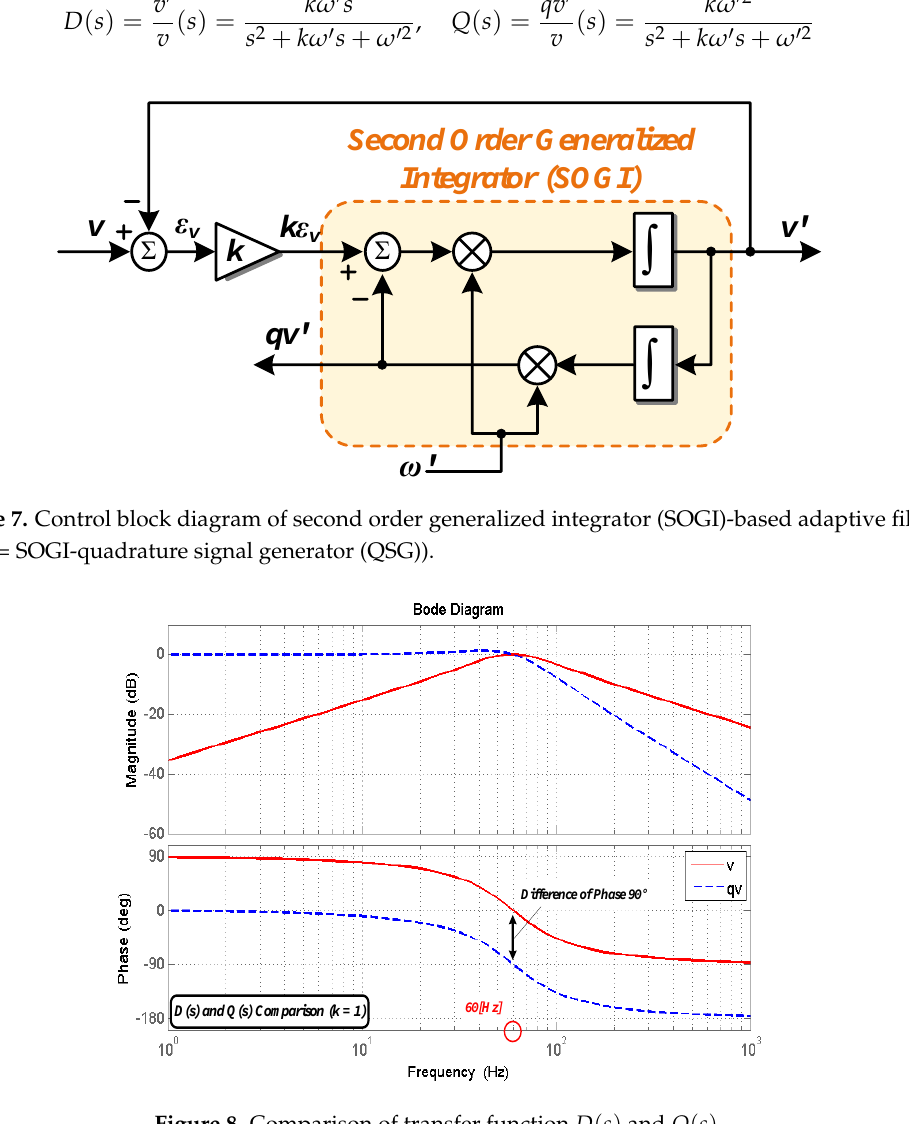
Figure 7. Control block diagram of second order generalized integrator (SOGI)-based adaptive filter (AF) (= SOGI-quadrature signal generator (QSG)).